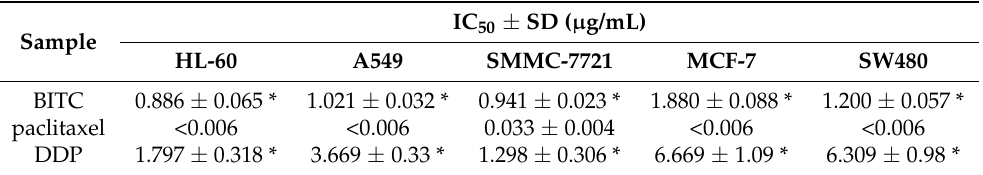
Table 3. The IC 50 values of BITC, paclitaxel, and cisplatin (DDP) on the five tumor cell lines, respectively.